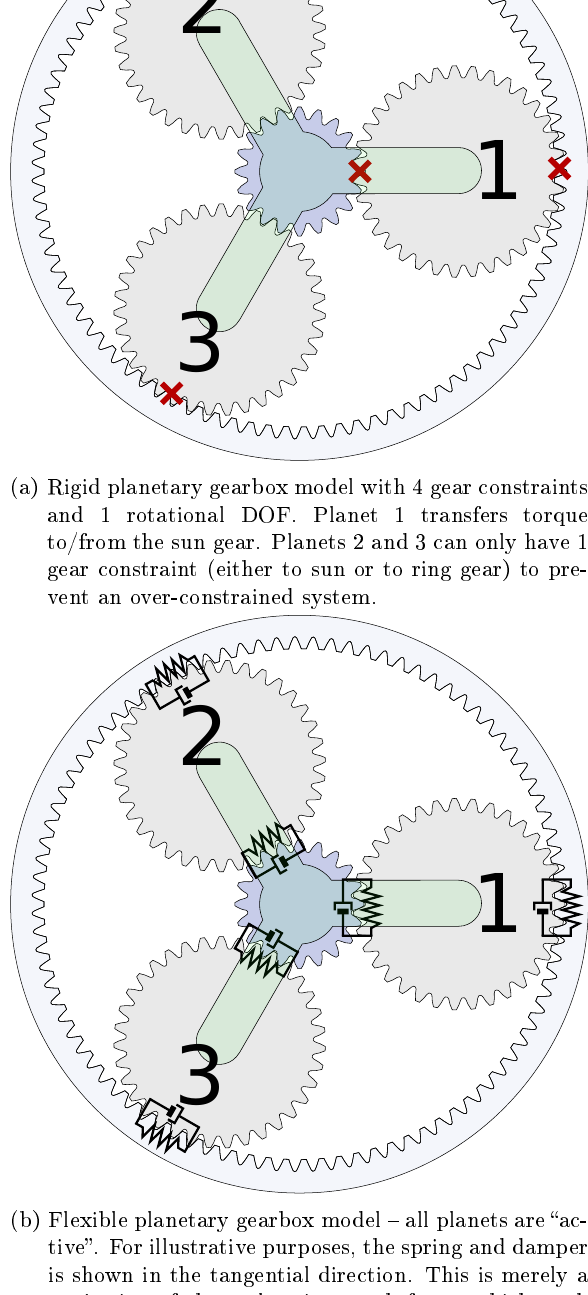
Figure 2: Di(cid:27)erence between rigid and (cid:29)exible 6-body multibody planetary gearbox